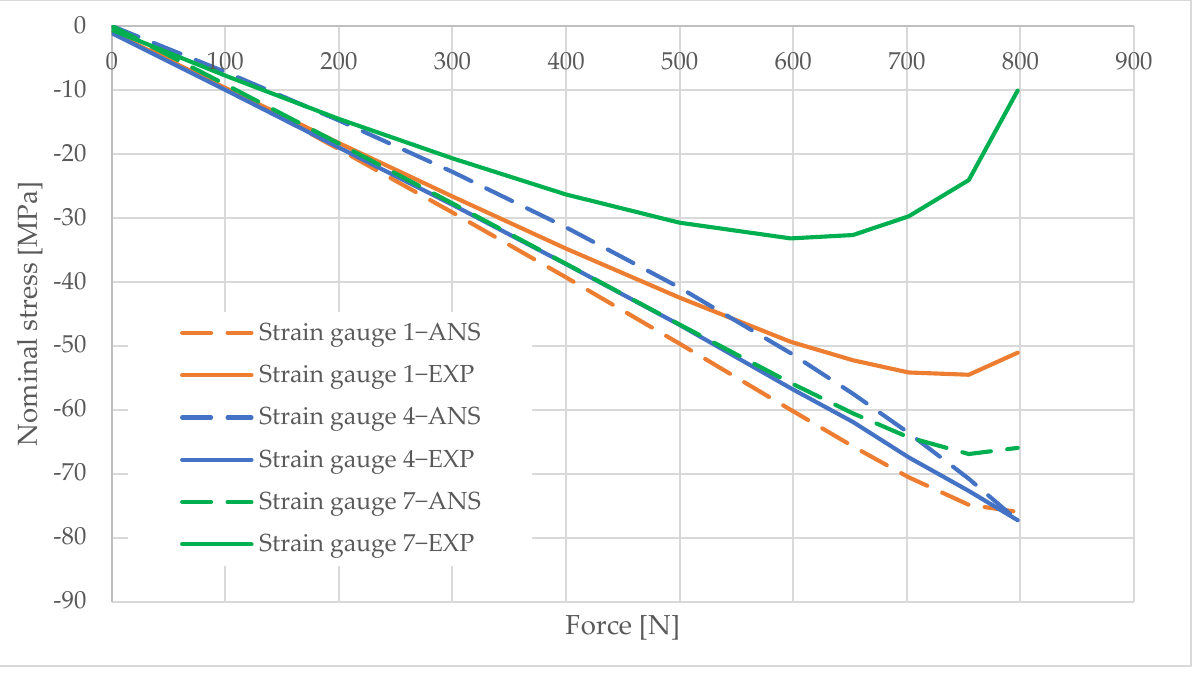
Figure 14. Pole 9/1 — values of normal stress readings from strain gauges no. 1, 4, and 7. Figure 14. Pole 9/1—values of normal stress readings from strain gauges no. 1, 4, and 7. When comparing the stress graphs at the strain gauge locations glued on opposite sides of the laminate, a bifurcation of the function could be observed. This indicates the moment of loss of stability by the wall located near the door opening. The strain gauge located on the inside of the laminate (inside the column) showed an additional increase in compressive stresses. On the diagram for the outer side gauge, the influence of additional tensile stresses, reducing the stress values, can be seen. This was due to the wall of